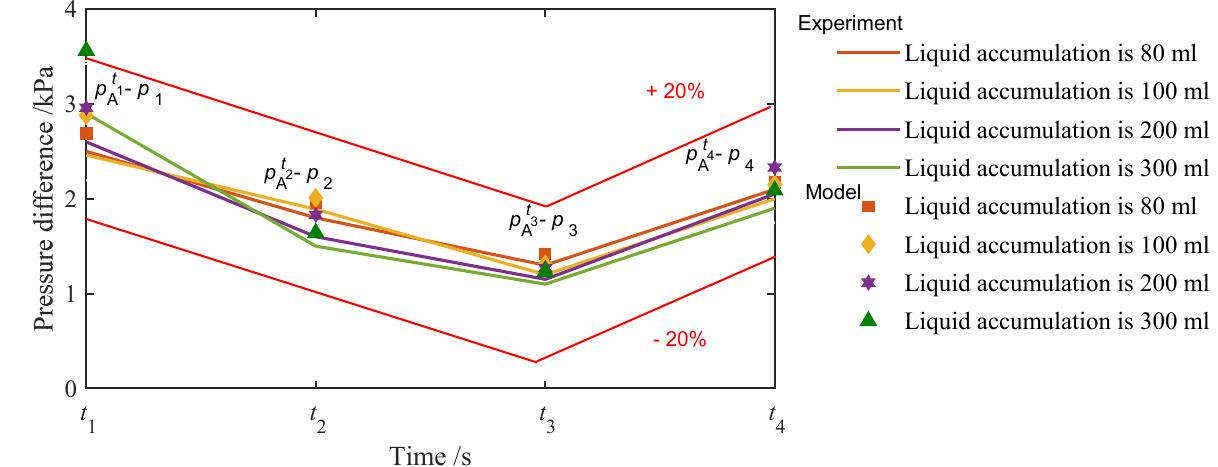
Figure 7. Verification of slug flow pressure model with an inclination of 5°.